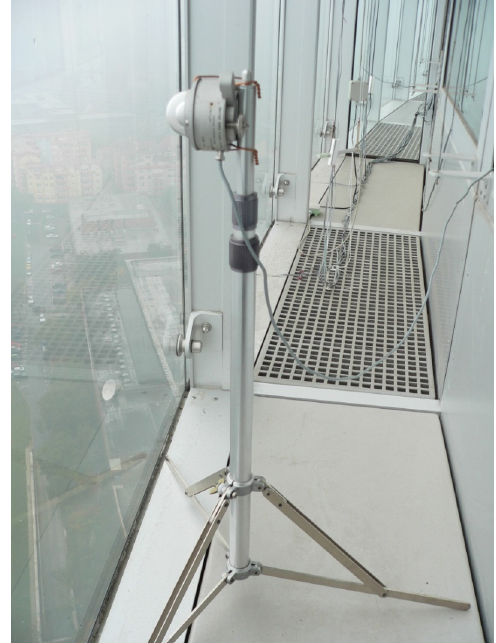
Figure 11: View into the cavity of a double skin facade with installed sensors of physical quantities